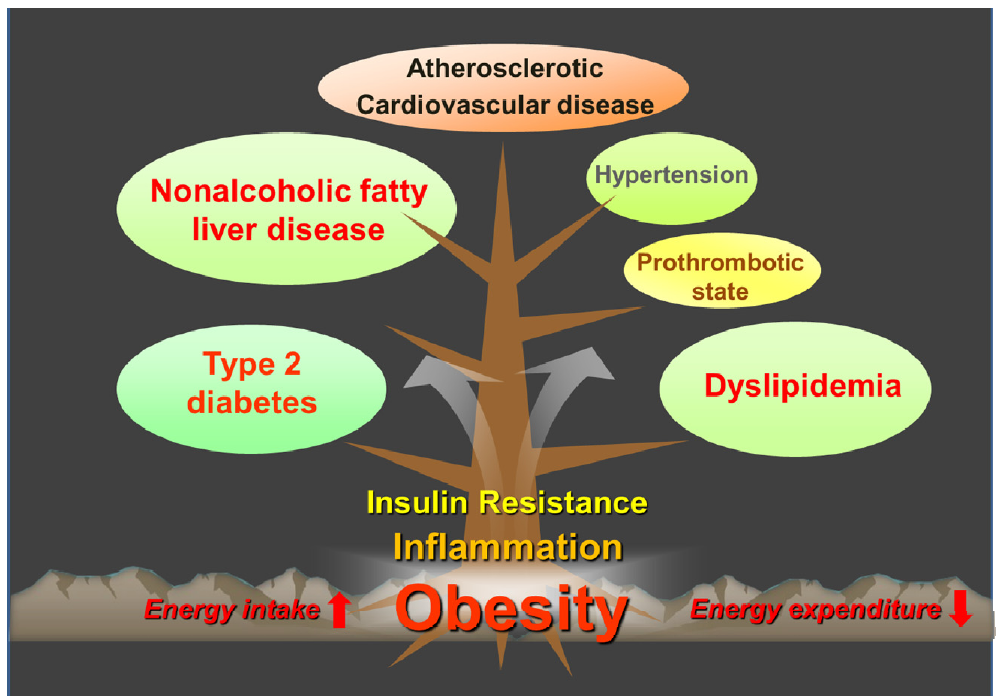
Figure 1. Concept of metabolic